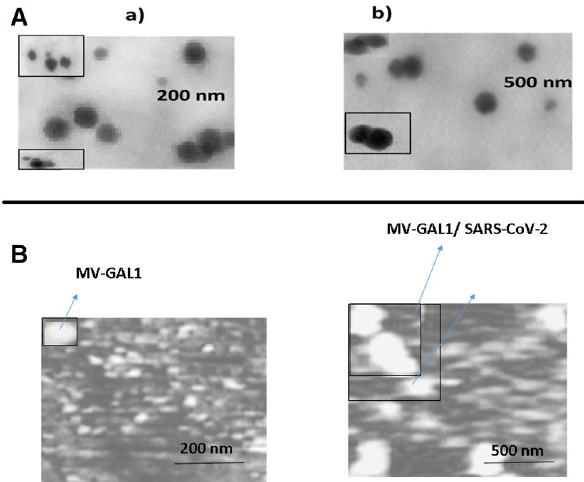
Figure 4. ( A ) TEM images of MV-gal1 (a) and MV-gal1@SARS-CoV-2 virus (b) to show the modified SCPE/ GNP. ( B ) AFM images when adding of MV-gal1 (a) and MV-gal1@SARS-CoV-2 virus (b) were occurred on the